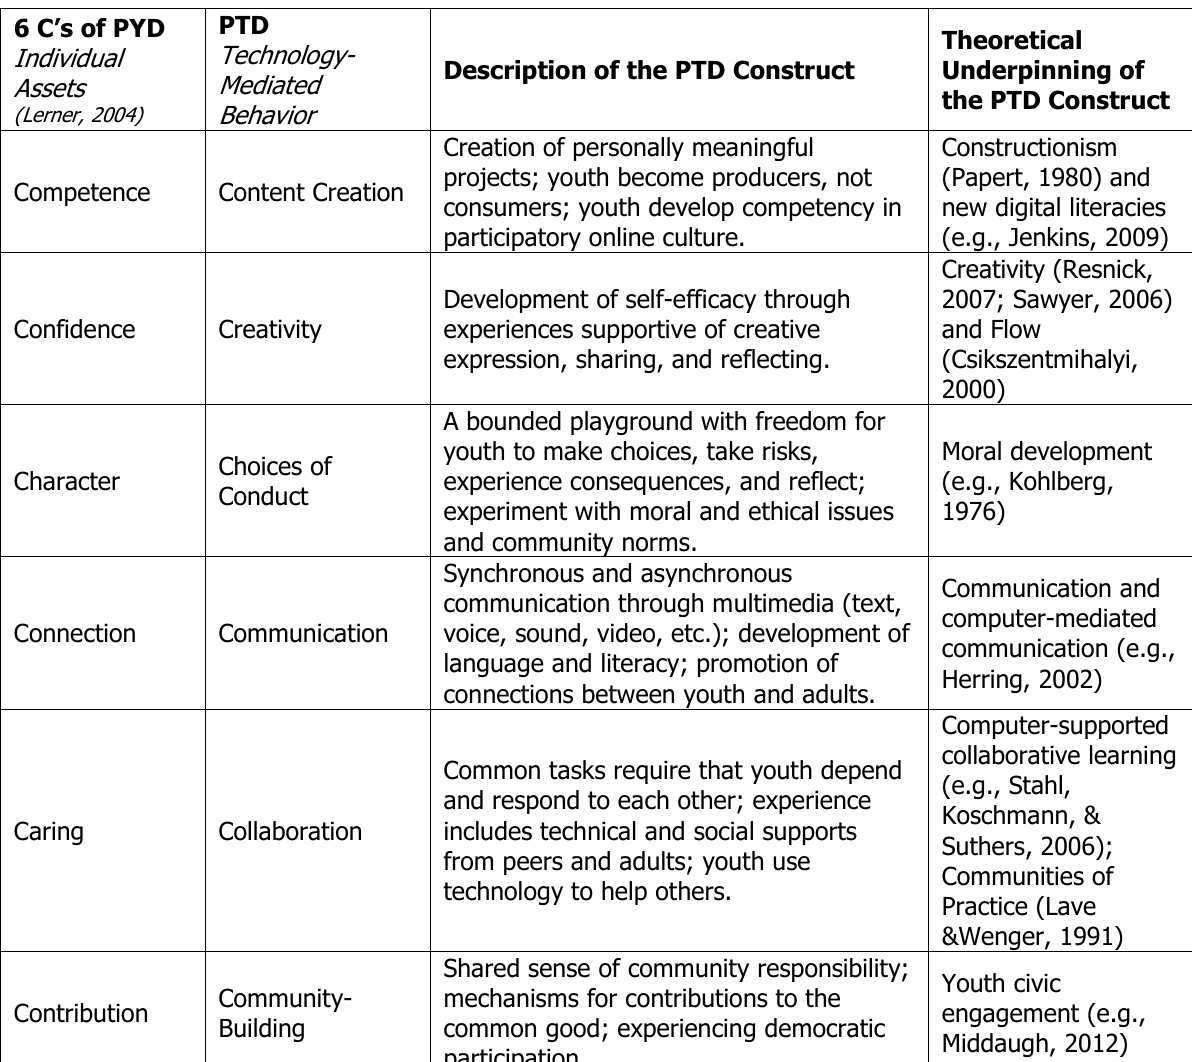
Connections between the 6 C’s of Positive Youth Development (PYD) and Positive Technological Development (PTD) 6 C’s of